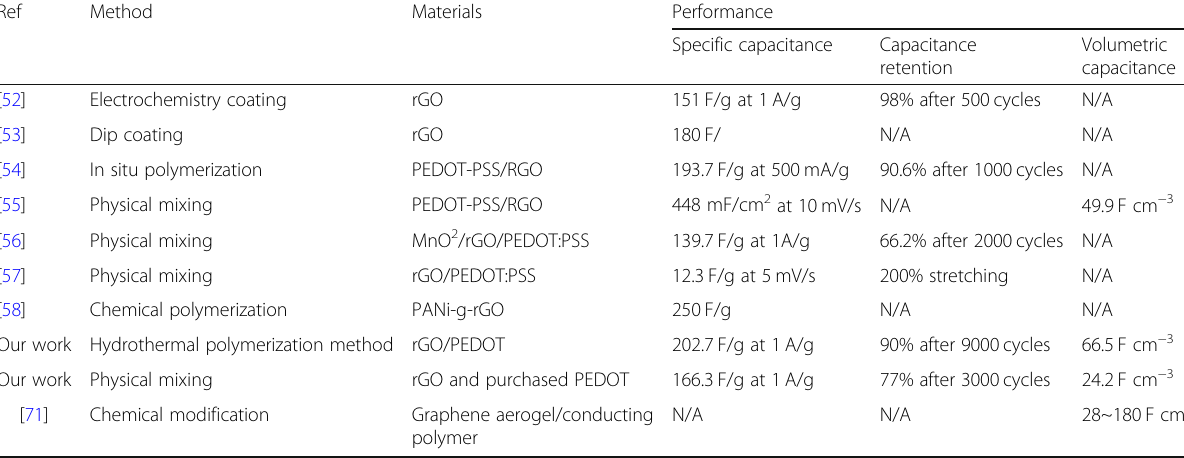
Table 3 Comparison of our work with reported